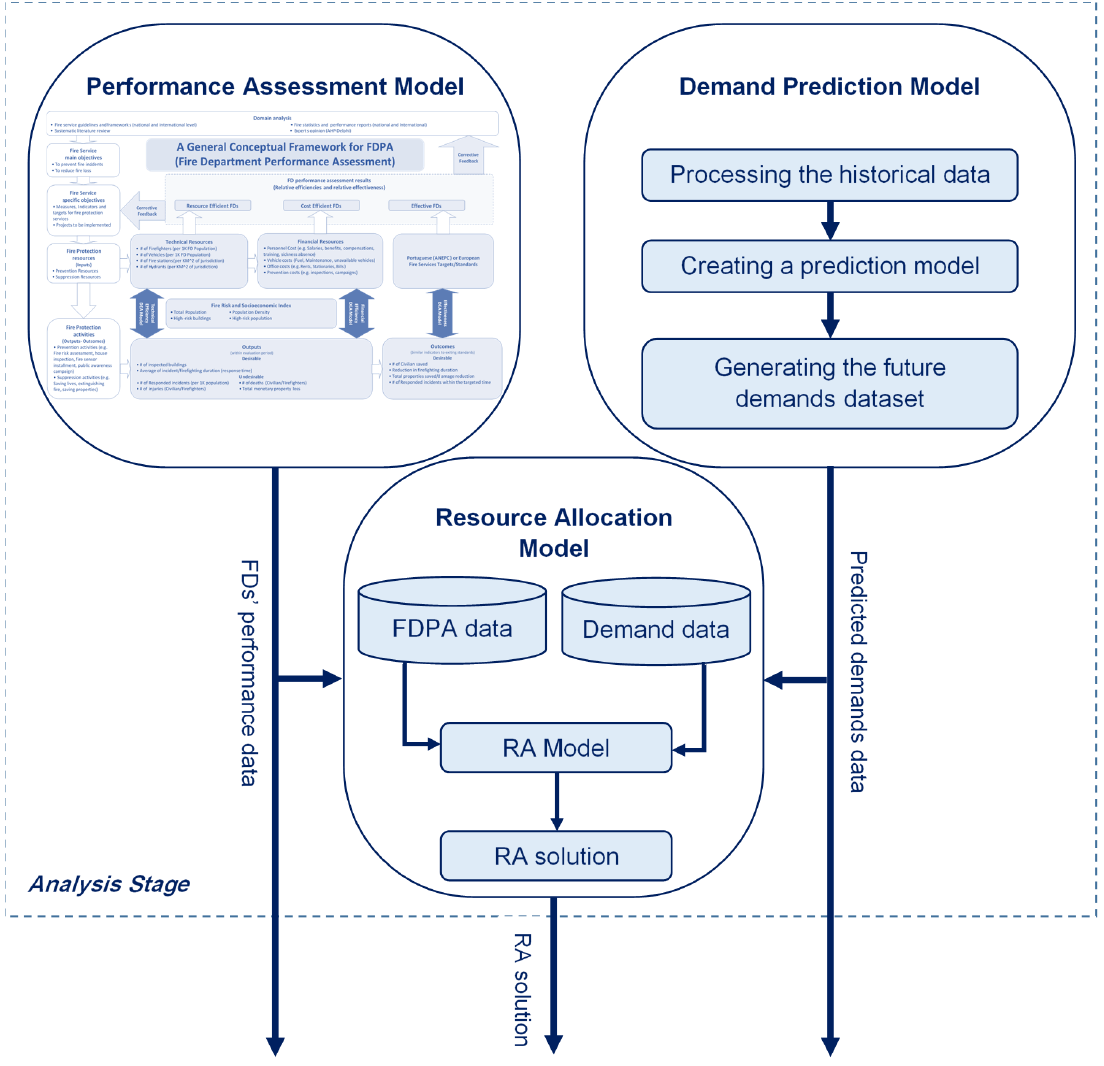
Figure 5. The detailed view of the analysis stage of the general RAFD framework (the image of the performance assessment model or FDPA framework obtained from [2]; please read this reference for further details).